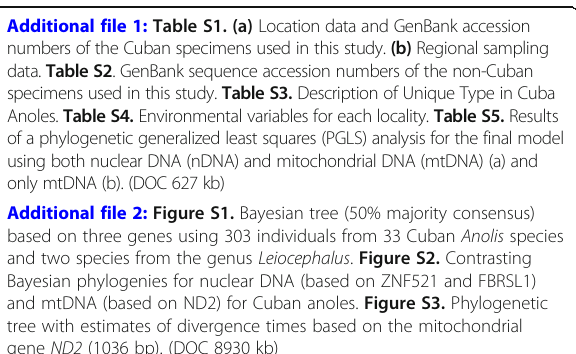
data. Table S2 . GenBank sequence accession numbers of the non-Cuban specimens used in this study. Table S3. Description of Unique Type in Cuba Anoles. Table S4. Environmental variables for each locality. Table S5. Results of a phylogenetic generalized least squares (PGLS) analysis for the final model using both nuclear DNA (nDNA) and mitochondrial DNA (mtDNA) (a) and only mtDNA (b). (DOC 627 kb) Additional file 2: Figure S1. Bayesian tree (50% majority consensus) based on three genes using 303 individuals from 33 Cuban Anolis species and two species from the genus Leiocephalus . Figure S2. Contrasting Bayesian phylogenies for nuclear DNA (based on ZNF521 and FBRSL1) and mtDNA (based on ND2) for Cuban anoles. Figure S3. Phylogenetic tree with estimates of divergence times based on the mitochondrial gene ND2 (1036 bp). (DOC 8930